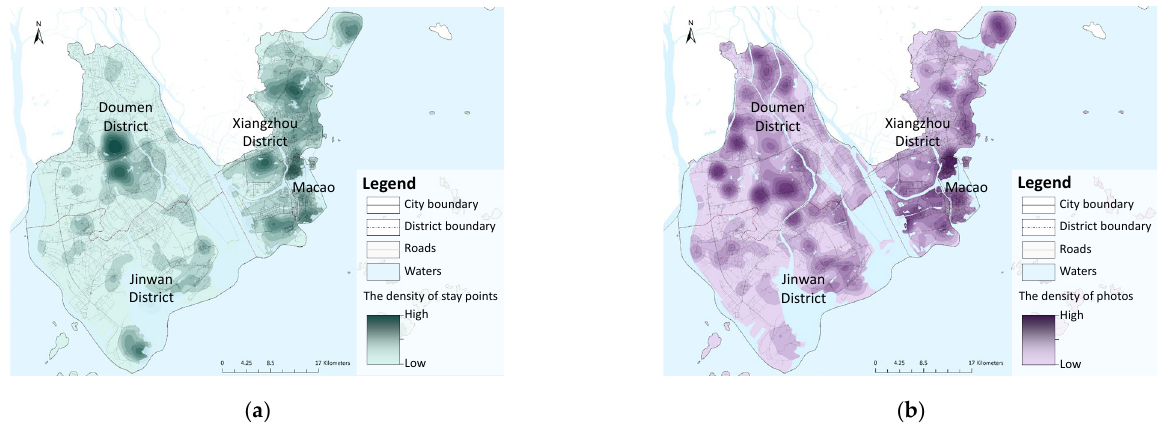
Figure 5. The density analyses: ( a ) Density of stay points; ( b ) Density of stay photos.